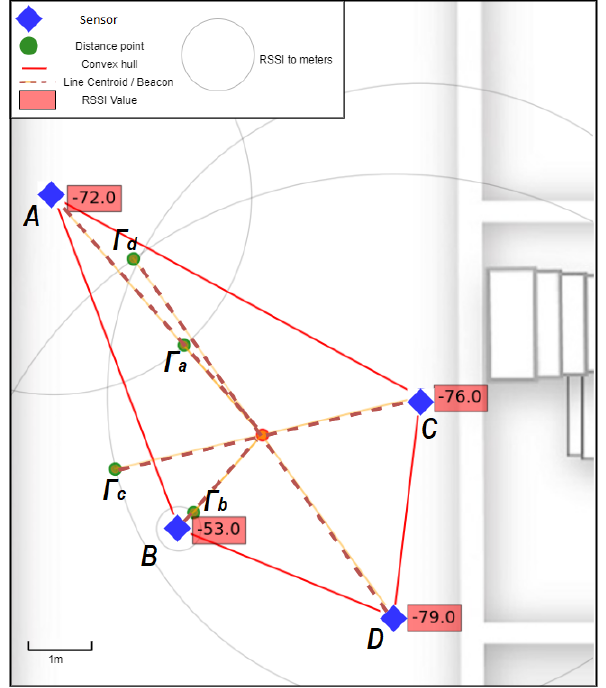
Figure 5. Convex hull of actives sensors at n = 0.